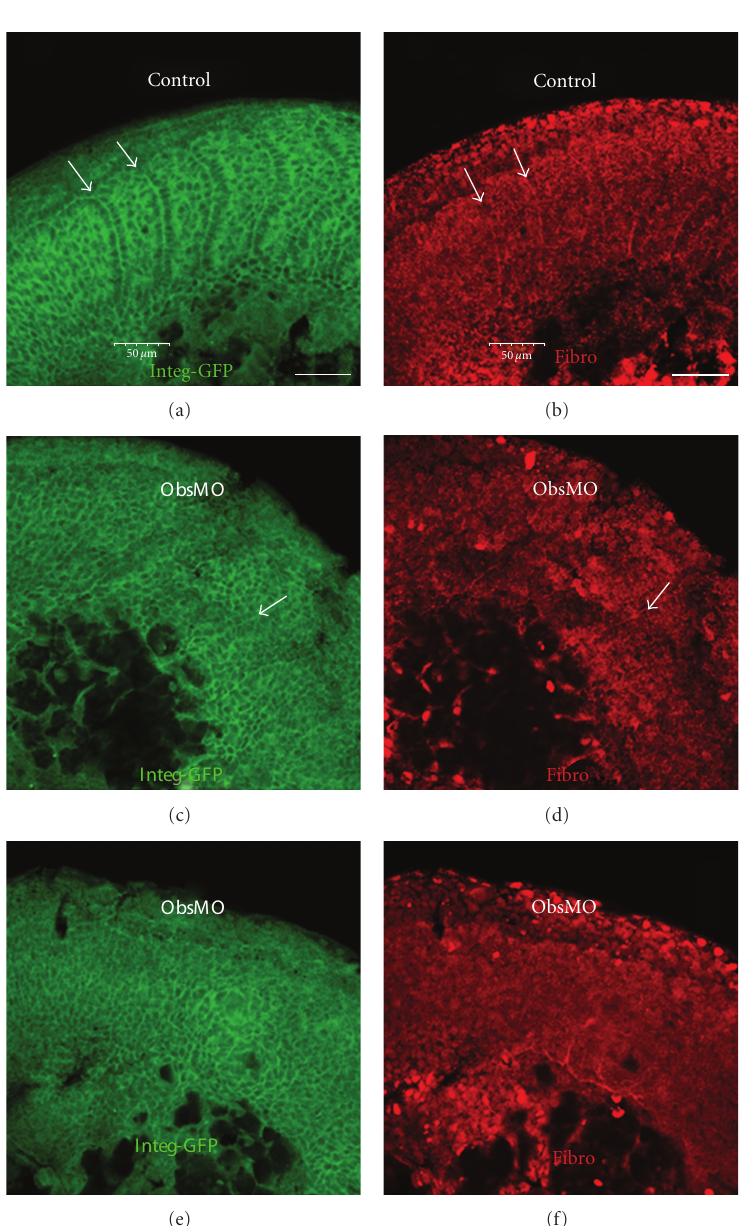
Figure 3: Integrin clustering is impaired in zebrafish embryos depleted of obscurin A. Zebrafish embryos were injected with GFP- α 5- integrin mRNA and then immunolabeled with anti-GFP (green: (a), (c), (e)) and antifibronectin (red: (b), (d), (f)) antibodies at 18 hours after fertilization (hpf). (a), (b) In control embryos, fibronectin matrix is organized at sites where α 5-integrin has clustered along a nascent somite boundaries (arrows). (c)–(e) In mildly a ff ected (c), (d) and more markedly a ff ected (e), (f) obscurin-A-depleted embryos, there is reduced apical clustering of integrins along nascent boundaries, although in the few instances where there is significant integrin clustering, fibronectin is organized ((c), (d): arrows). Scale bars are 50 μ